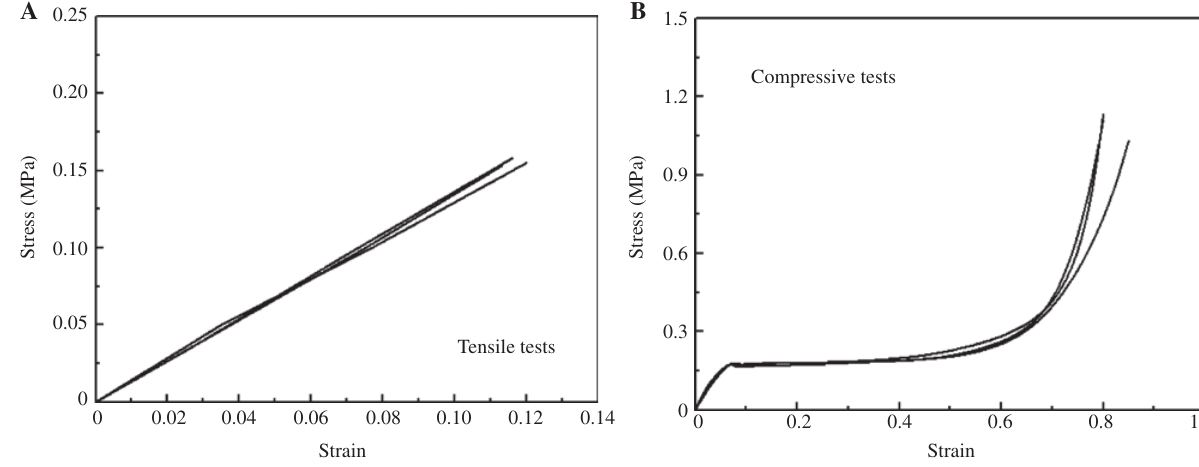
Figure 4: Stress-strain curves for foam core (A) tensile tests and (B) compressive tests.